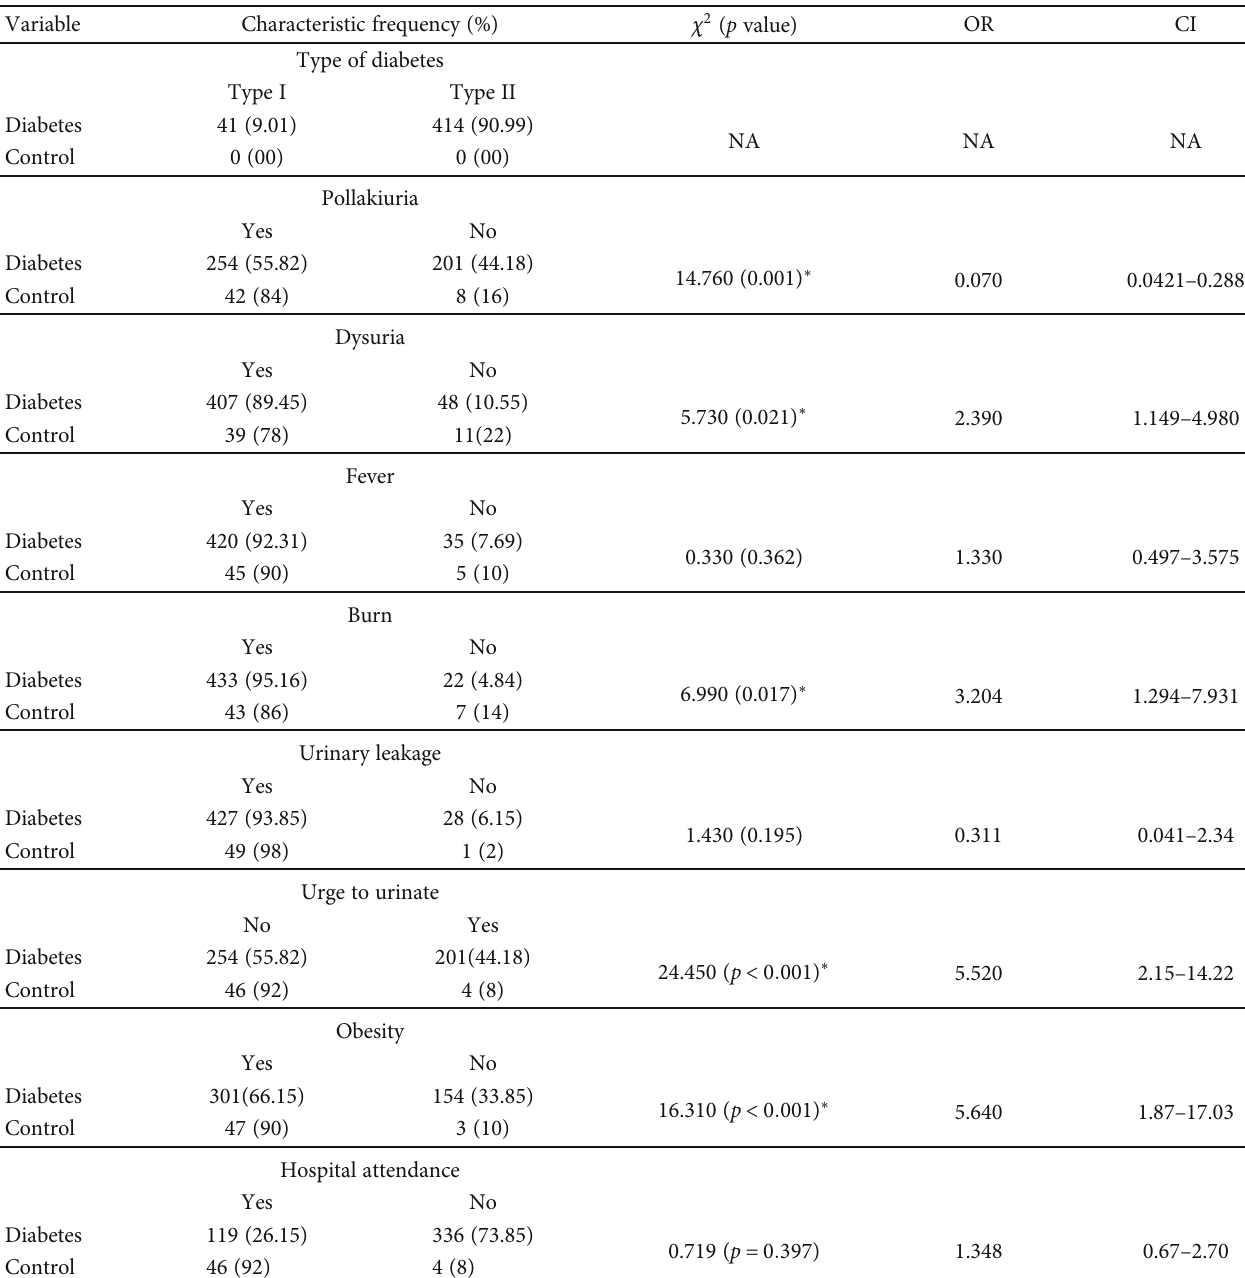
Table 3: Clinical features of the diabetic and nondiabetic study